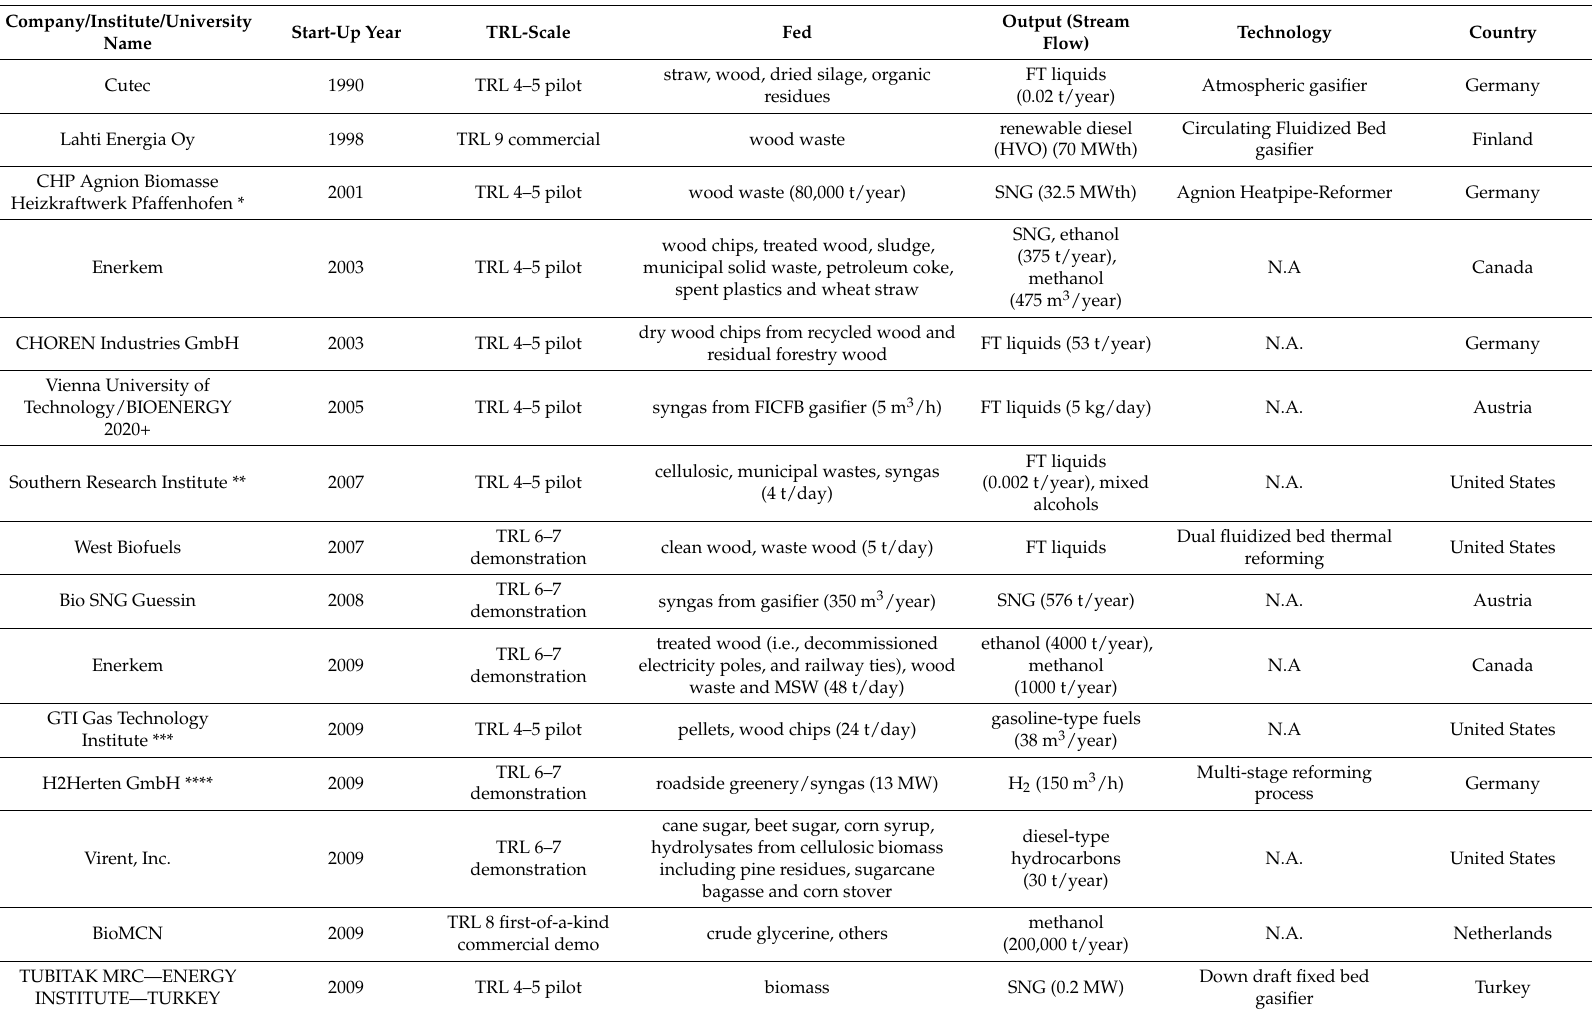
Table 8. Worldwide second-generation biofuel plants (self-processed data from IEA T33 database